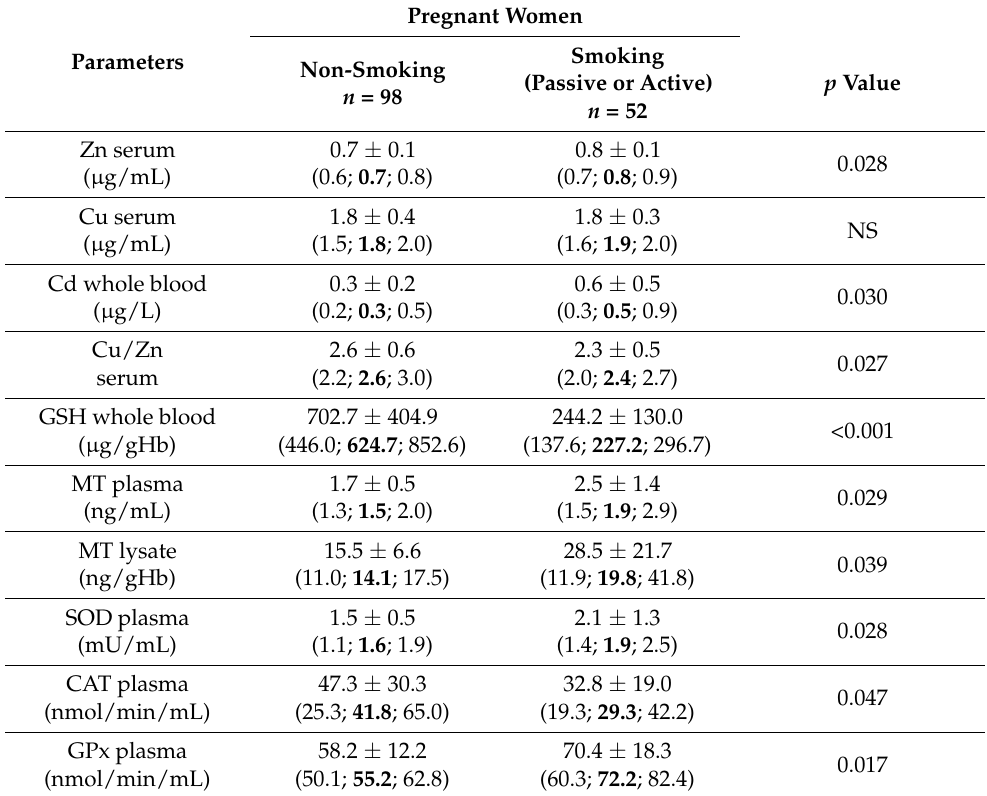
Table 4. Values of selected antioxidative parameters, and metals in pregnant women non-exposed or exposed (passive or active) to tobacco smoke.